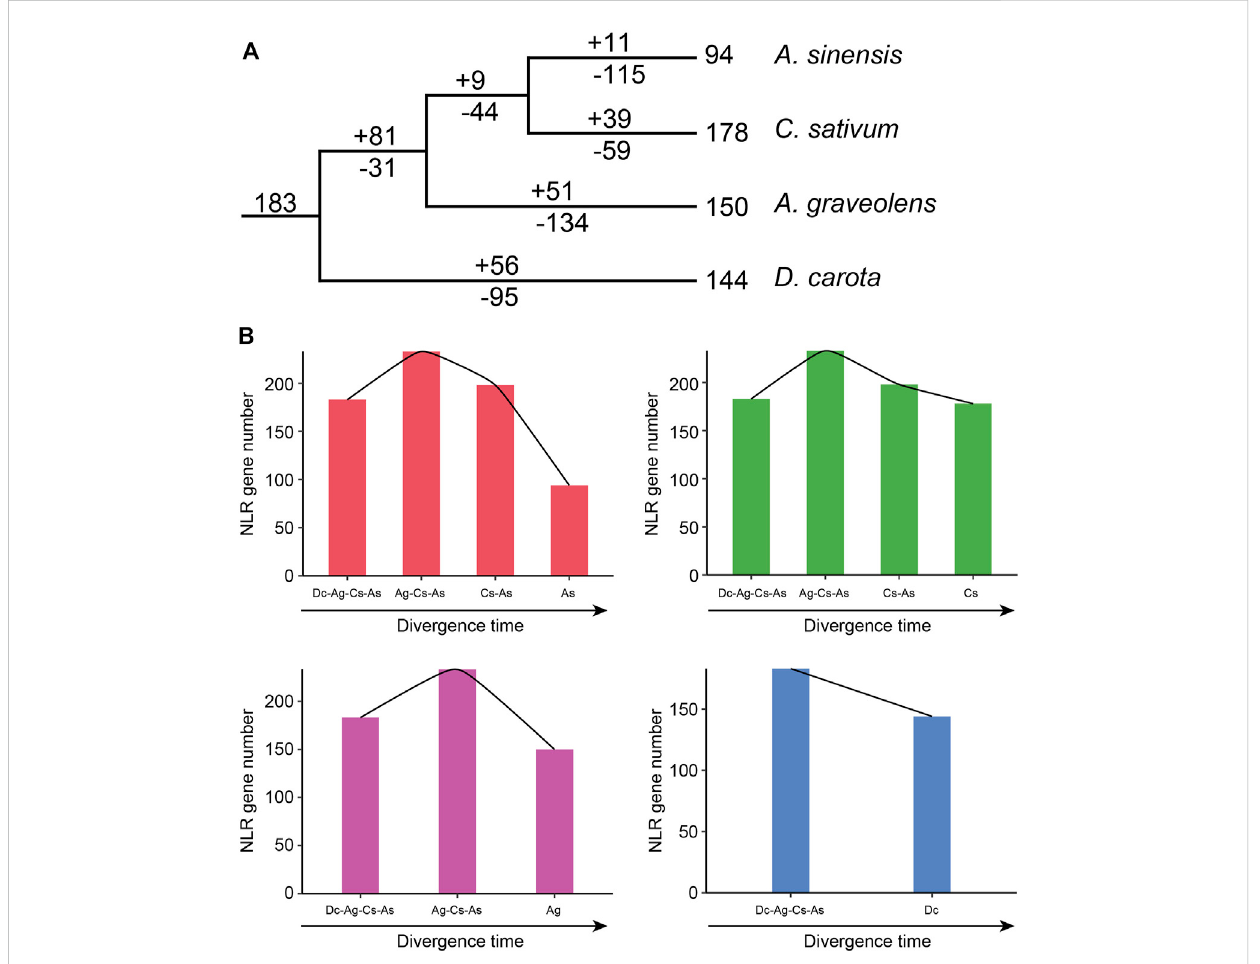
FIGURE 5 Evolutionary trajectory of NLR genes during Apiaceae species speciation. (A) Number variations of NLR genes at different stages of four Apiaceae species. Differential gene-gain and loss events are indicated by numbers with + or - on each branch. (B) Dynamic evolutionary patterns of NLR genes at different stages of four Apiaceae species. As, A. sinensis ; Cs, C. sativum ; Ag, A. graveolens ; Dc, Daucus carota